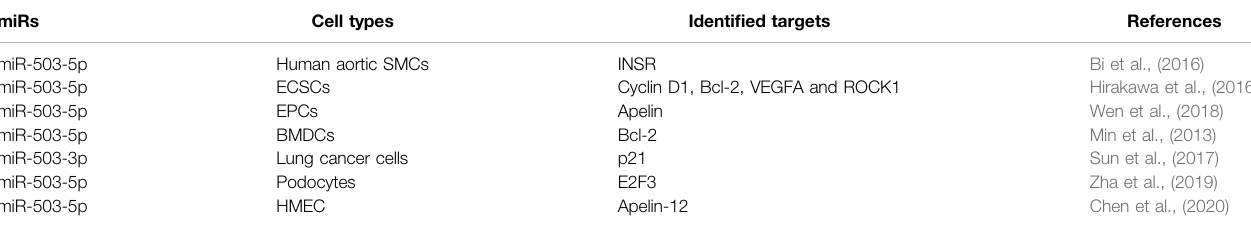
TABLE 1 | Roles of miR-503 in cells and its